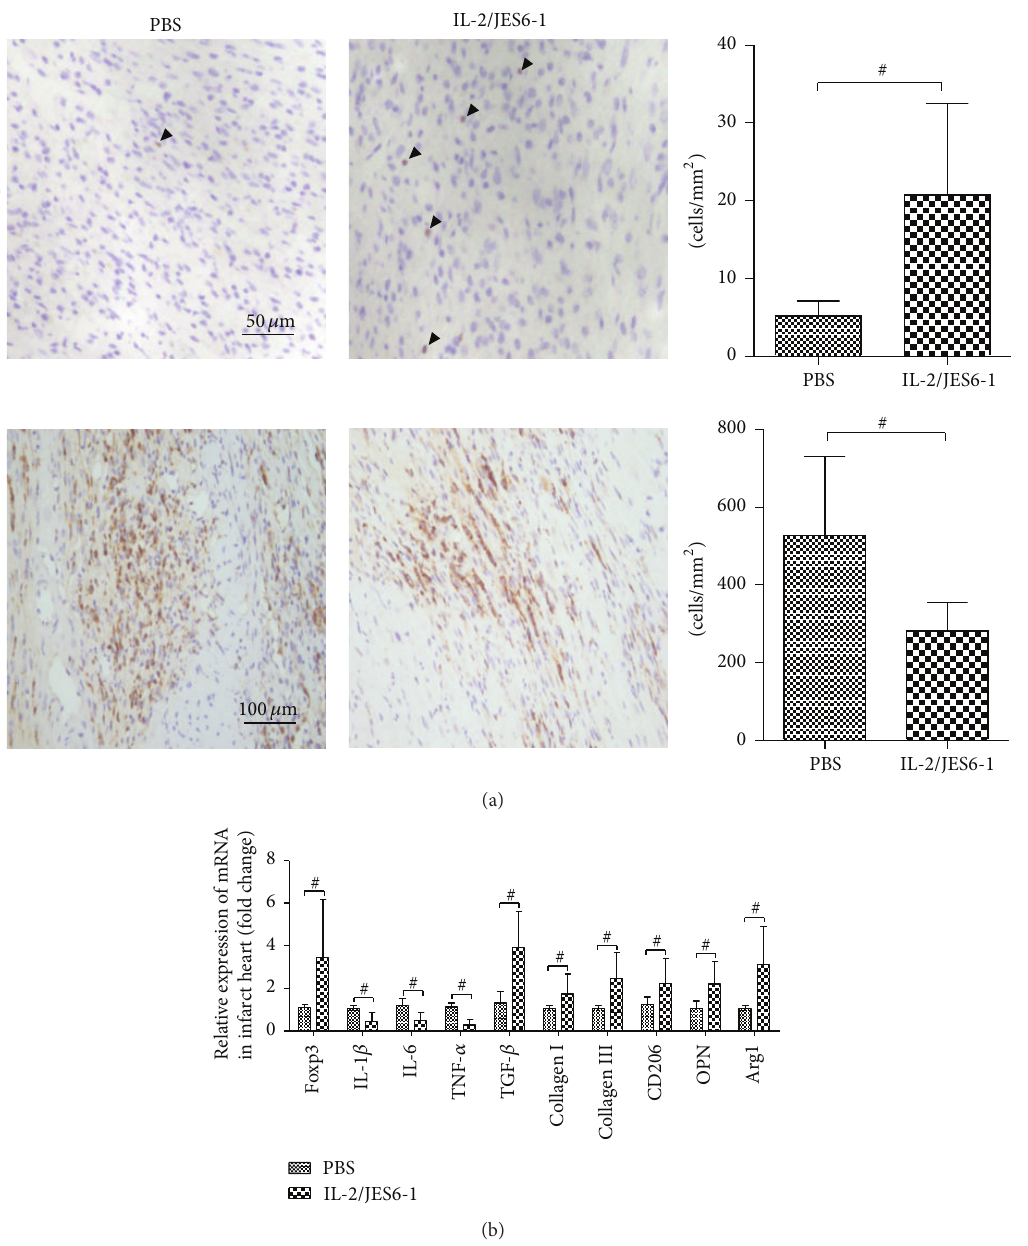
Figure 5: (a) The infiltration of Foxp3+ Treg cells and CD68+ macrophage in the infarcted heart was compared between the two groups ( 𝑛 = 6 per group) on day 5. Original magnification × 400 (upper), × 200 (down). (b) mRNA expression levels of cytokines and M1 and M2 macrophages markers in the infarcted heart at day 5. # 𝑃 < 0.05 versus the PBS